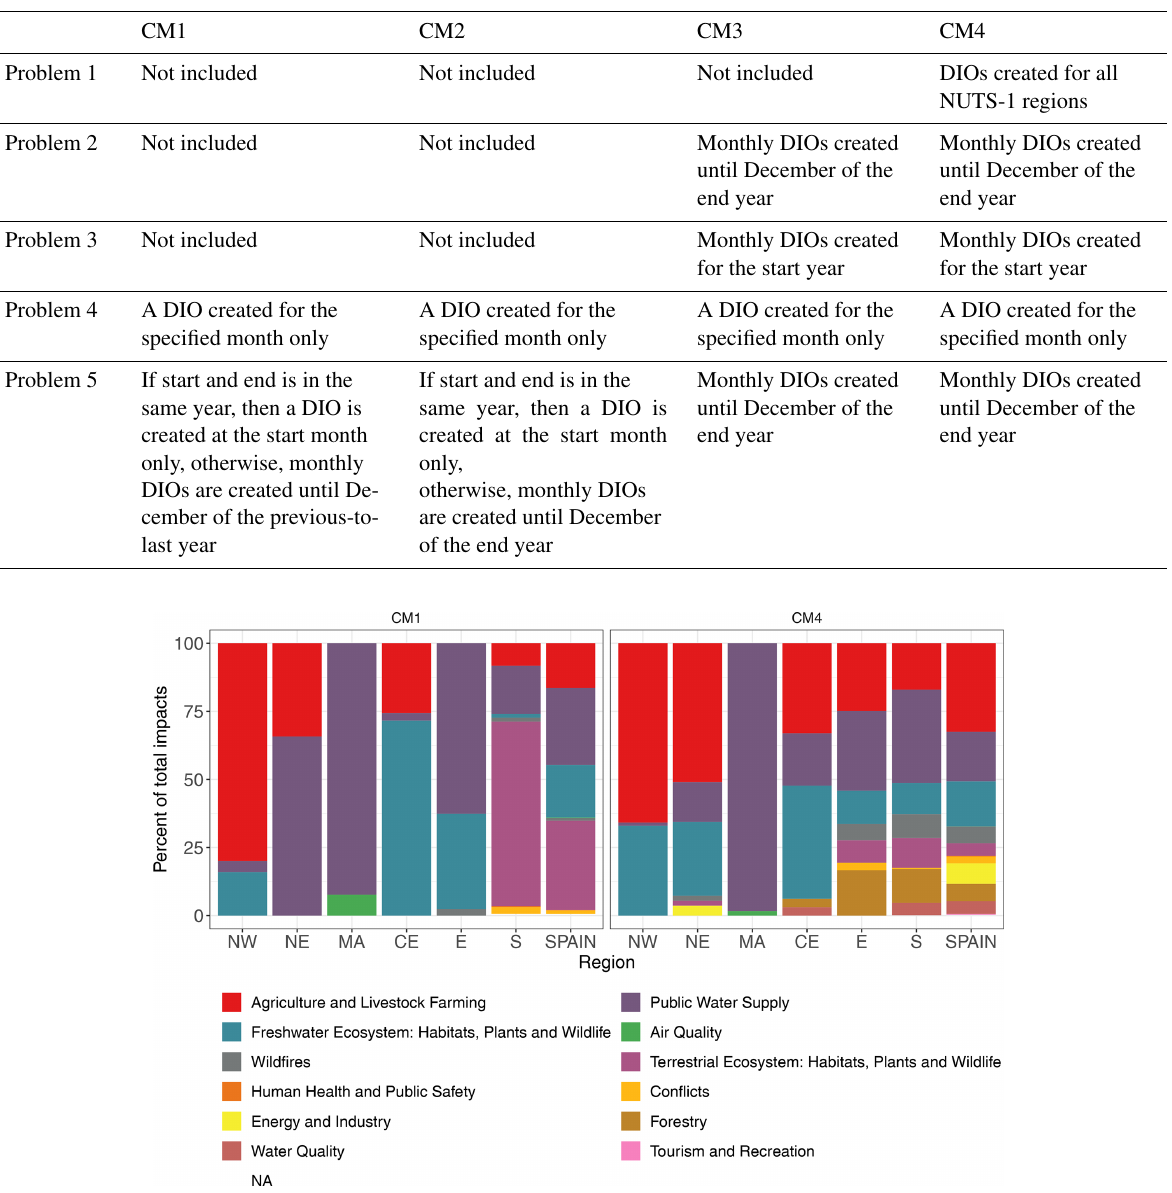
Figure 1. Distribution of impact types for Spain and the sub-regions studied. Results for the most and least censoring counting methods (CM1 and CM4) are